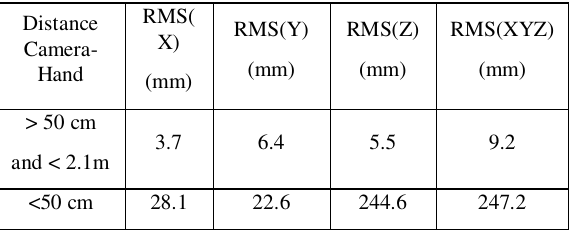
Figure 10: Evaluation of the tracking process while varying the distance Camera-Hand Table 2: Accuracy of hand motion tracking with variation in the distance